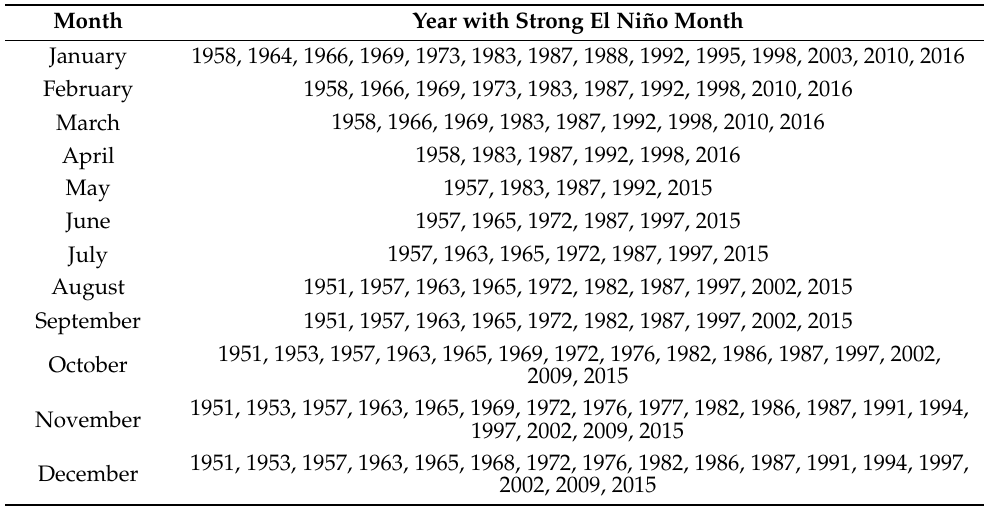
Table 1. The strong El Niño months in the period 1951–2017, categorized by month. Strong El Niño months are those in El Niño events and with ONI ≥